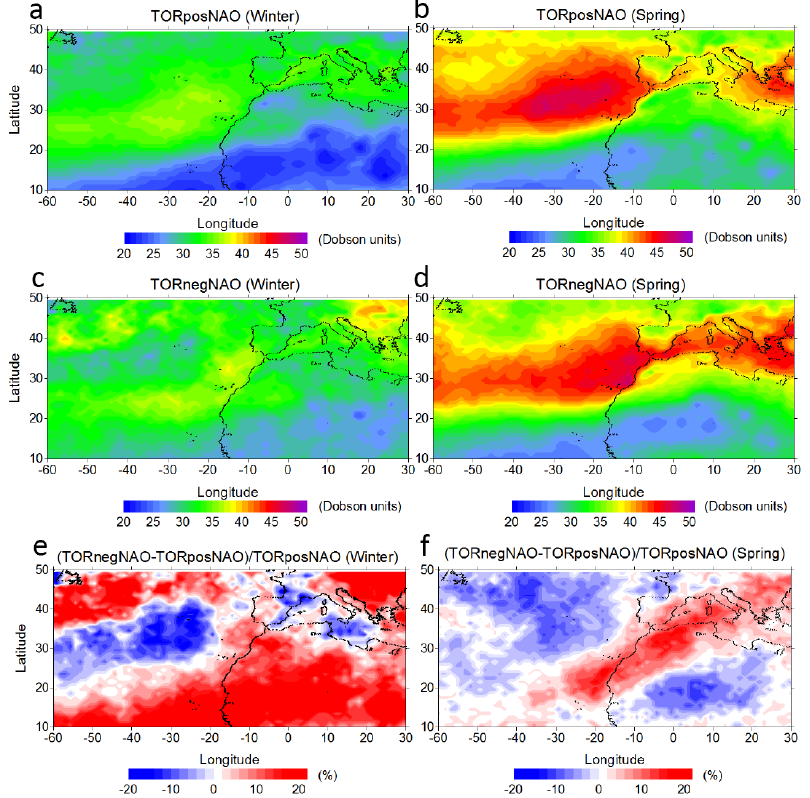
tween 1996 and 1998 (Fig. 3). This is in agreement with the flattening in surface O 3 series observed at European stations Fig. 15. Averaged tropospheric ozone residual (TOR) data (in Dobson units) in winter (JFM) and spring (AMJ) for years with NAO > + 0 . 5 Fig. 15. Averaged Tropospheric Ozone Residual (TOR) data (in since the late 1990s (e.g. Ord´o˜nez et al., 2007; Gilge et al., (a, b) and for years with NAO < − 0 . 5 (c, d) . Percentage differences between TOR with negative NAO, and TOR with positive NAO in winter Dobson units) in winter (JFM) and spring (AMJ) for years with 2010; Logan et al., 2012). and spring, respectively (e, f) . NAO > +0 . 5 (a,b) and for years with NAO < − 0 . 5 (c,d). Percent- age differences between TOR with negative NAO, and TOR with sults of finding simultaneous positive O 3 –CO correlation and positive NAO in winter and spring, respectively (e,f). positive O 3 –PV max and O 3 – 7 Be correlations in winter and